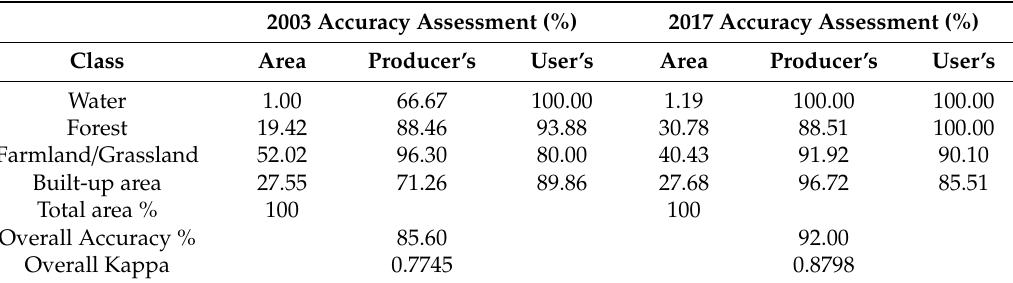
Table 3. Accuracy assessment results of SPOT images.